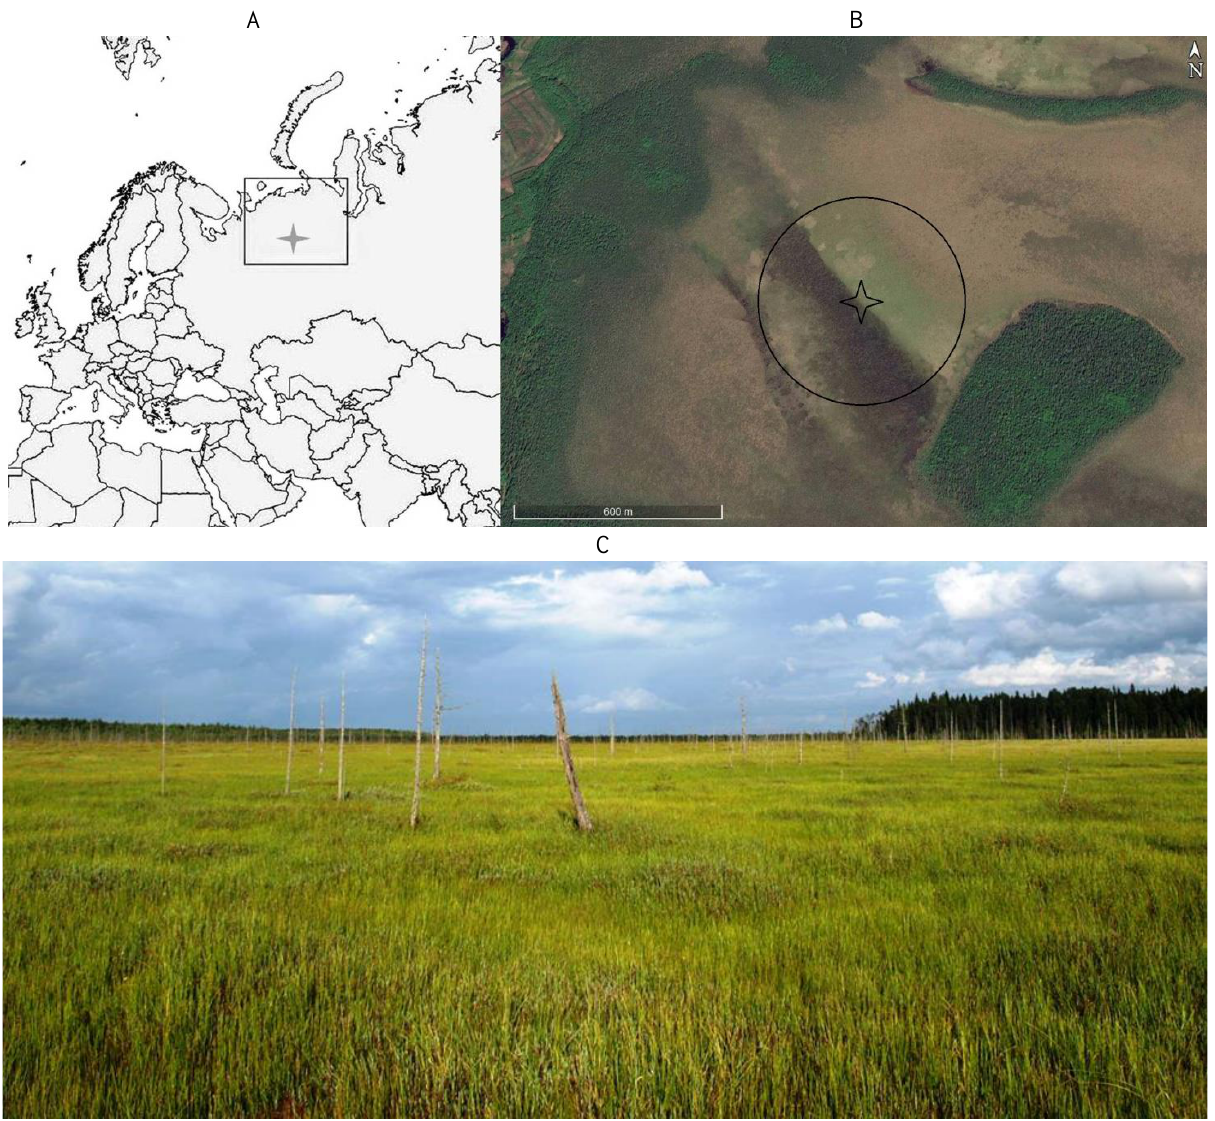
Figure 1. Study site (Medla-Pev-Nyur (Ust-Pojeg) peatland). A: map of Europe showing the location of the study site; B: location of the eddy covariance tower on the study site; C: typical landscape of the study